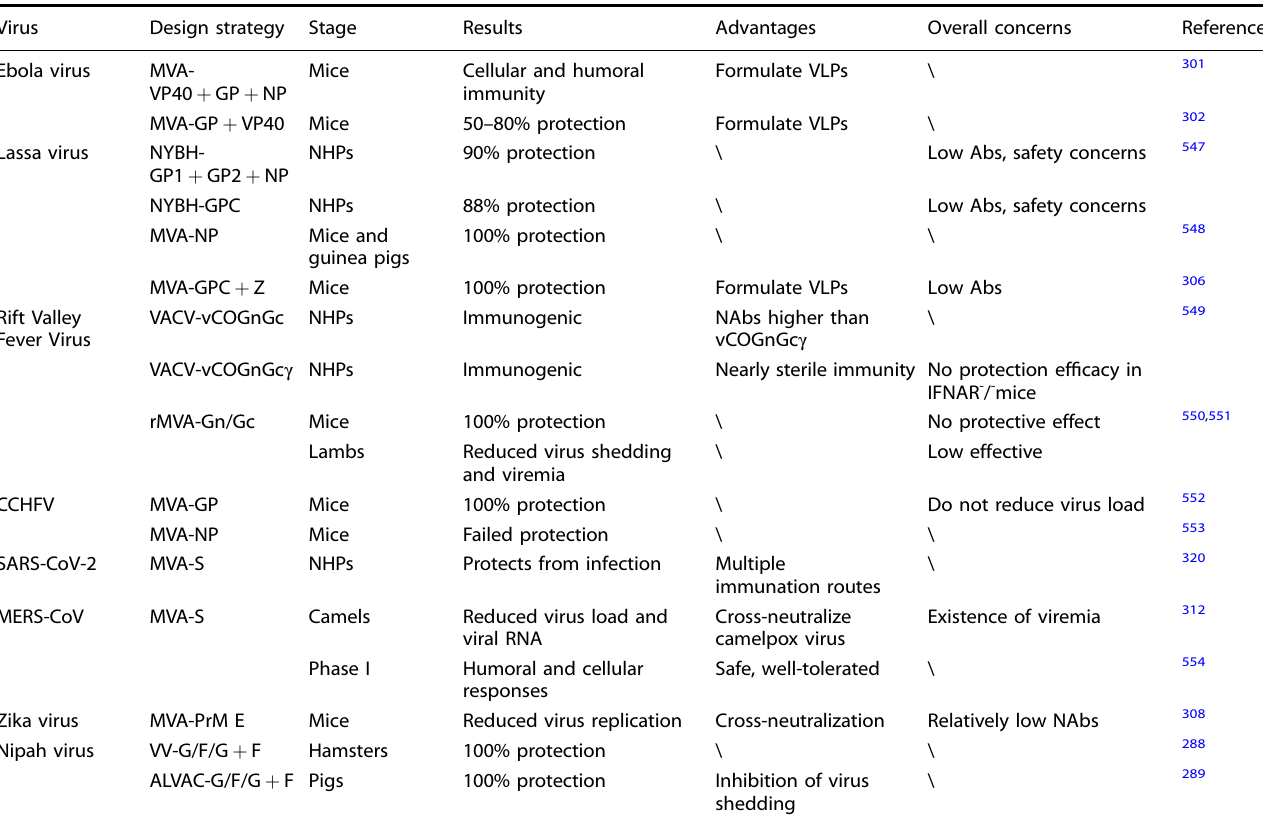
Table 9. Vaccine candidates based on poxvirus vector Virus Design strategy